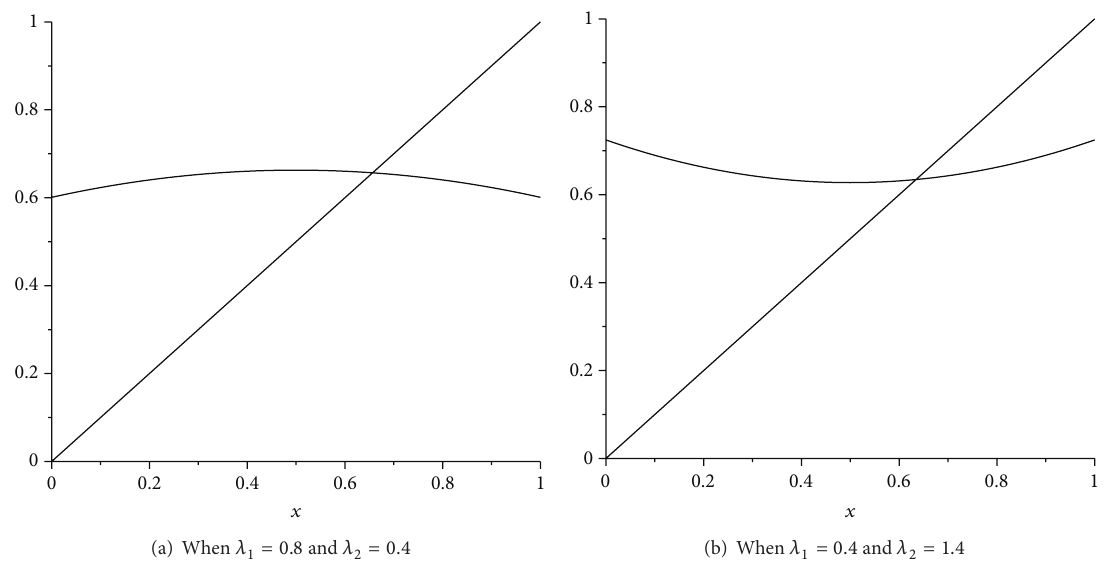
Figure 1: Graph of the function (21) for some fixed values 𝜆 1 and 𝜆 2